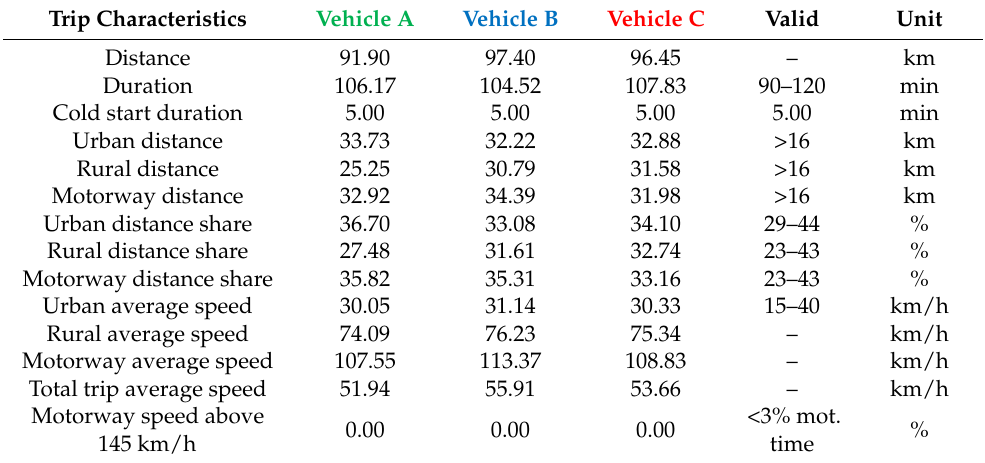
Table A1. Characteristic data of the performed tests and their comparison with the admissible